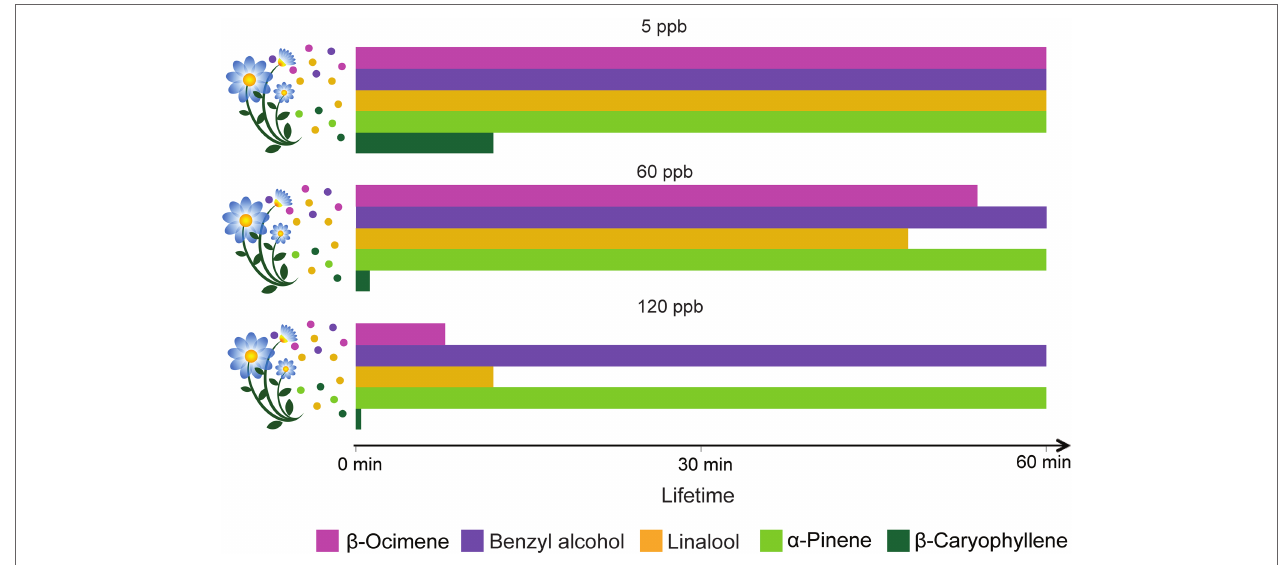
FIGURE 3 | Effect of ozone concentration on odor plume composition over time. Lifetimes in the atmosphere, measured up to 60 min, of volatiles emitted commonly by flowers ( β -ocimene, benzyl alcohol, and linalool) and by leaves (linalool, α -pinene and β -caryophyllene) are presented under the influences of the O 3 levels indicated above the histograms. The degree of O 3 reactivity is based on the structural properties of the VPCs (Atkinson and Arey,